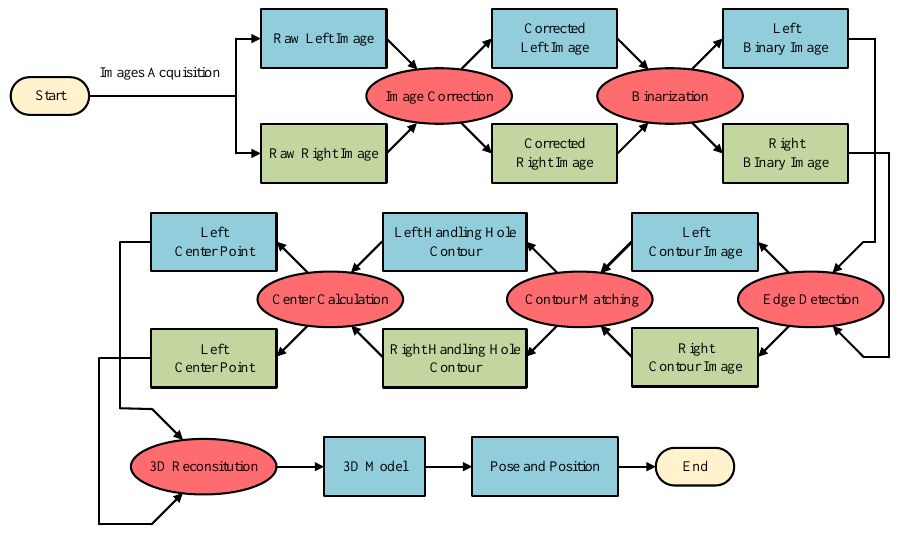
Figure 17. Flowchart of the true value calculation.